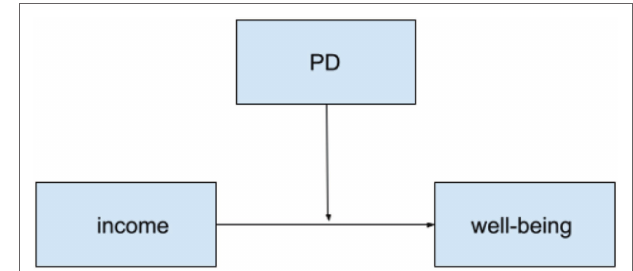
FIGURE 3 | Hypothesized two-way moderation model between PQI and PD on well-being for both countries.